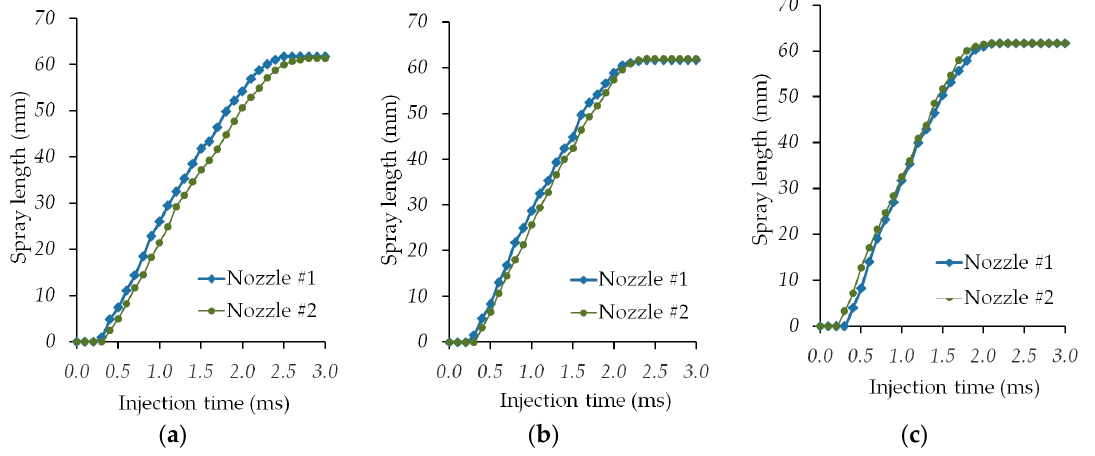
Figure 13. Dynamics of change in the average lengths of the fuel sprays of injectors at rail pressures of 100 ( a ), 130 ( b ), and 165 MPa ( c ).